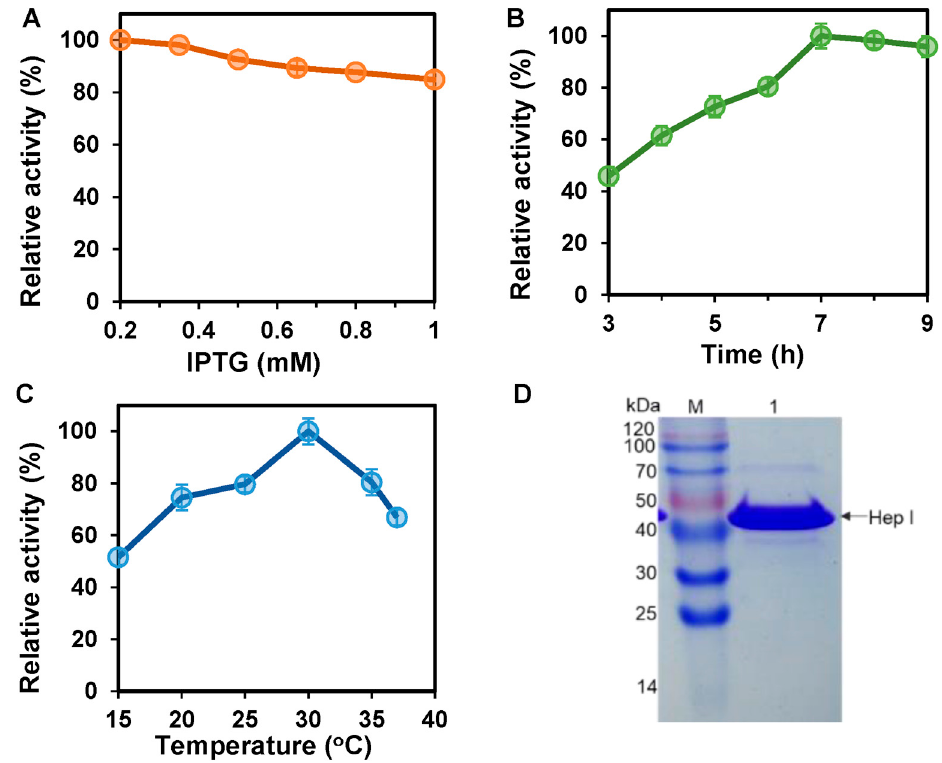
Figure 2. Expression and purification of BxHep-I. ( A ) Effect of IPTG concentration, ( B ) inducing time, and ( C ) temperature on the BxHep-I activity. ( D ) The SDS-PAGE image of the purified BxHep-I (M: protein molecular weight marker; lane 1: the purified BxHep-I).